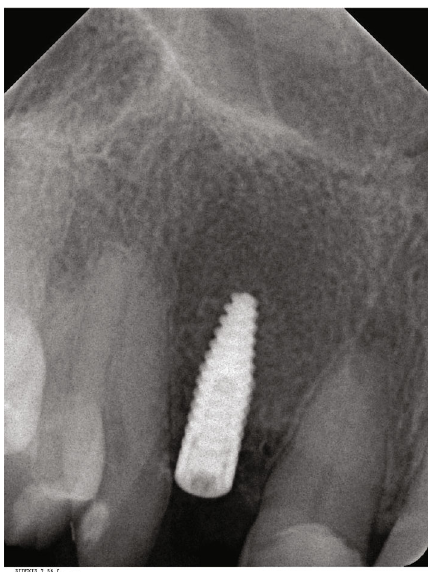
Figure 13: Dental X-ray after dental implantation.